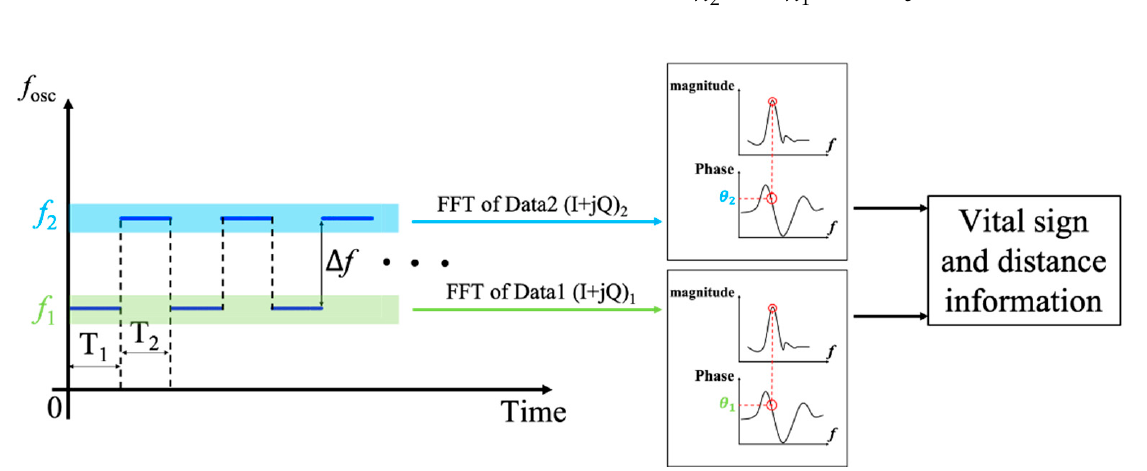
Figure 20. The block diagram of FSK signal processing under pulse-width modulation (PWM) control.